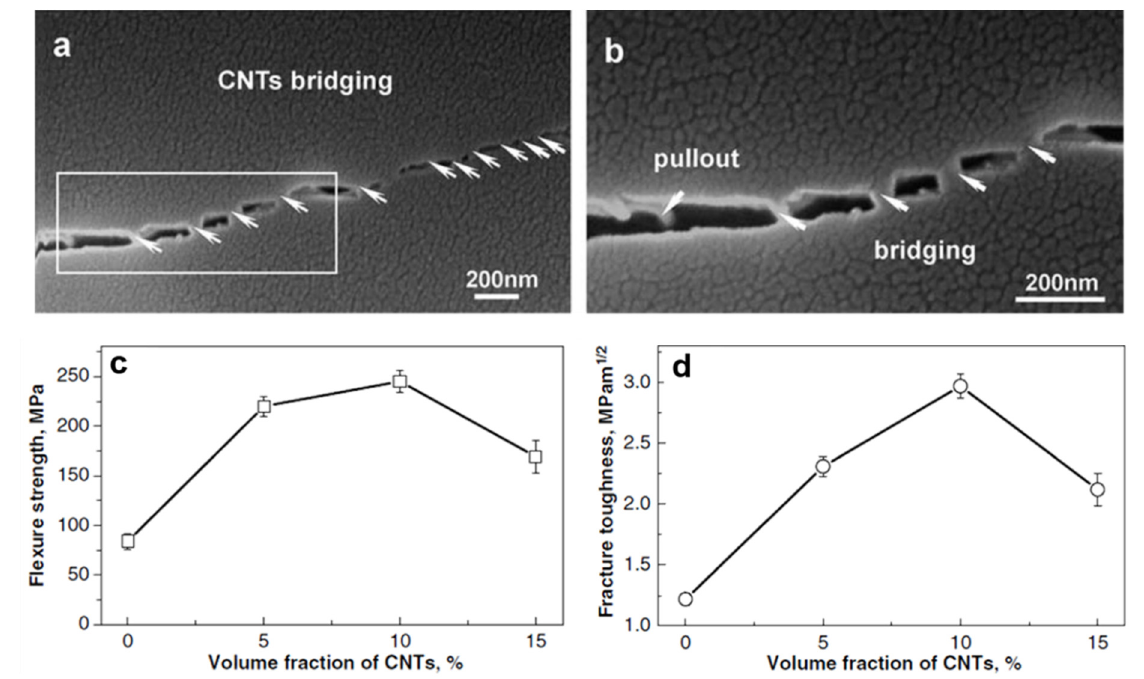
Figure 4. ( a , b ) Scanning electron microscope (SEM) micrograph of 10 vol.% CNTs-BAS composite upon indentation. The white arrows indicate the bridging effect of CNTs during the indentation crack propagation. ( b ) The enlarged micrograph from the white square section in ( a ), showing the CNTs pullout from the barium aluminosilicate (BAS) composite. ( c , d ) The flexural strength and fracture toughness peaked at the addition of 10 vol.% CNTs, which indirectly indicates that the practicable CNTs addition in the BAS composite is 10 vol.%. (Adapted with permission from ref. [70]. Copyright 2006 Elsevier).